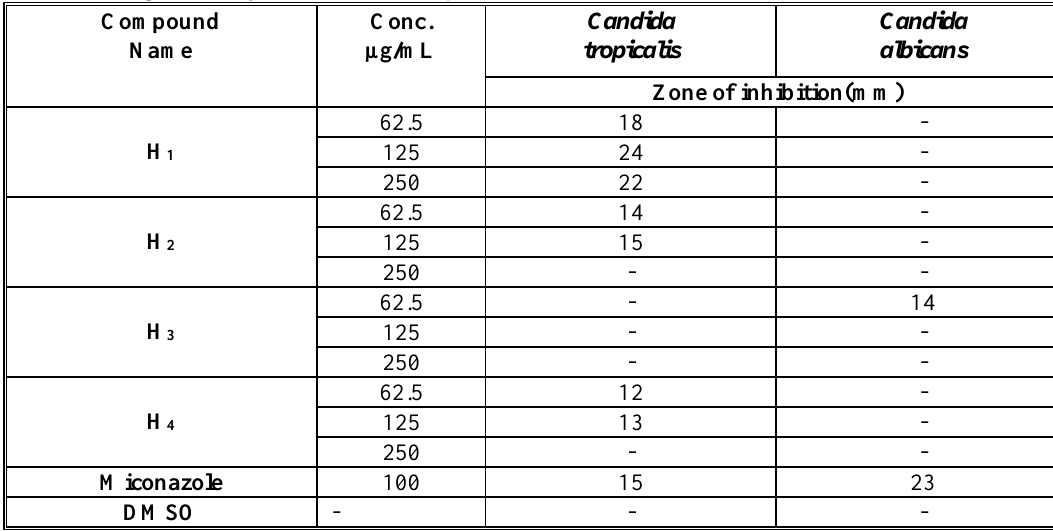
Table 2. antifungal activity of the tested compounds